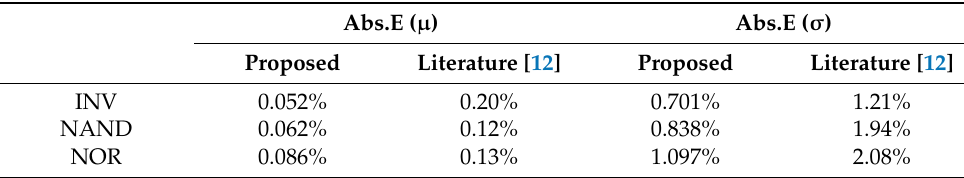
Table 5. Accuracy comparation with literature [12].